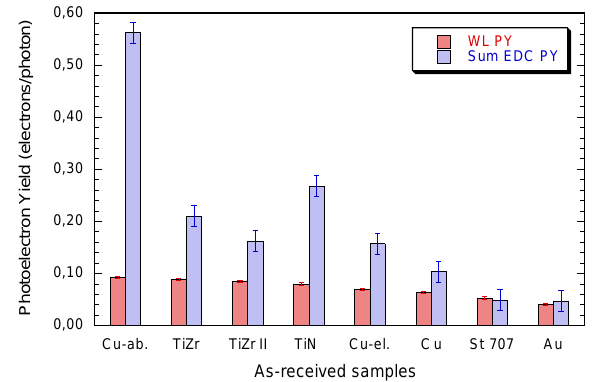
FIG. 18. (Color) A comparison between WL PY and its corresponding low photon dose WL PY generated from a summation of the acquired EDCs for the as-received samples. Error bars are those generated from the Au reconstruction.